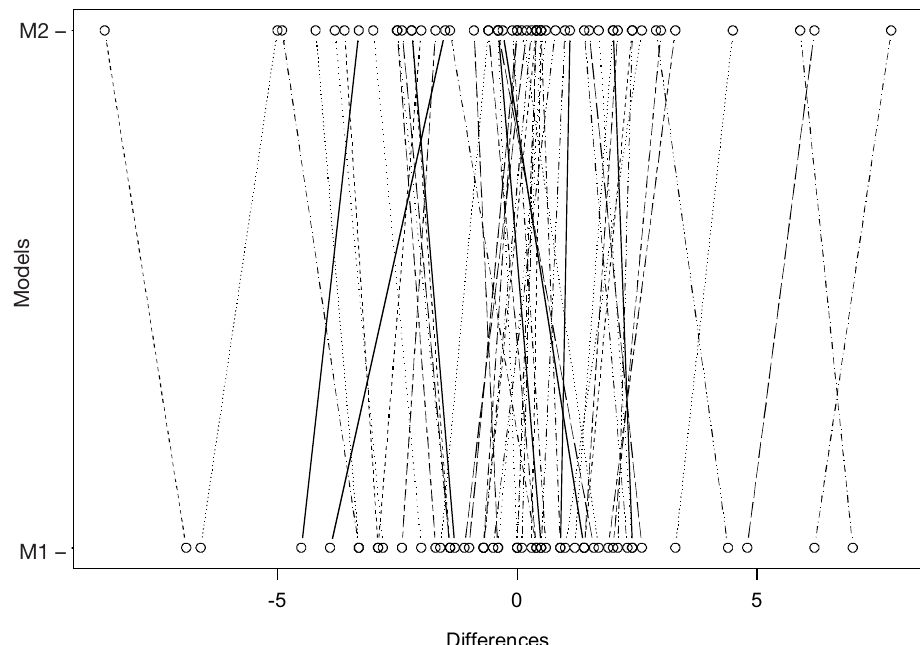
Fig. 1. Differences between models. Differences between expected and observed cell frequencies for model with (M1) and without (M2) interaction are shown in the plot. Straight lines connect values referred to the same cell under the two models.